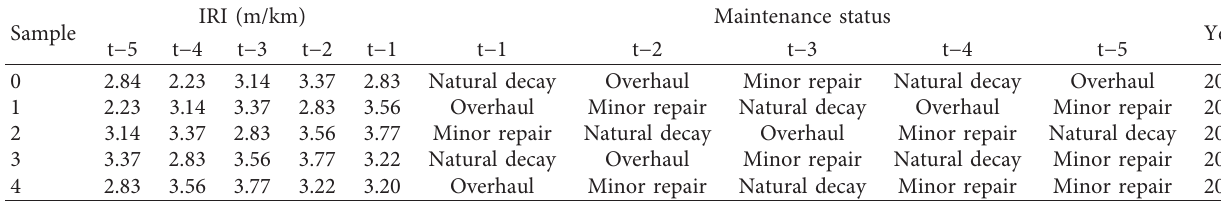
Table 2: Extraction results of time series feature.